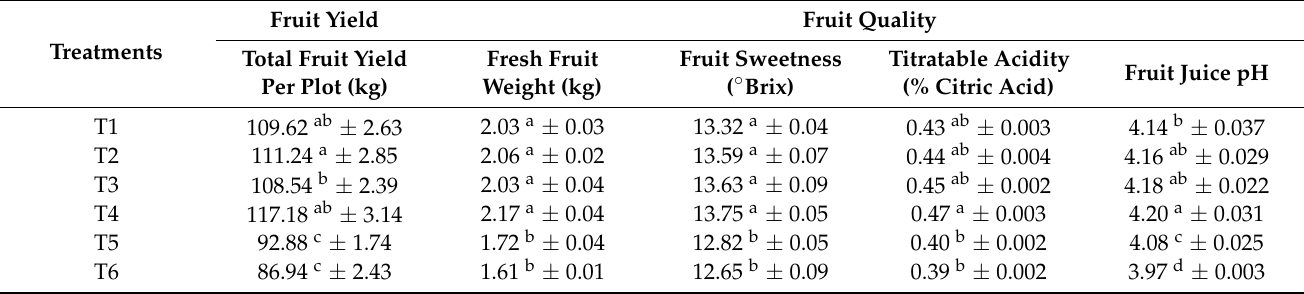
Table 7. Fruit yield and fruit quality characteristics of Ananas comosus L. Merr var Moris in a tropical peat soil treated with different amounts of clinoptilolite zeolite and compound NPK